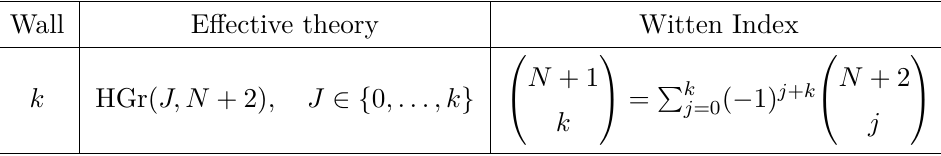
Table 2 . The k +1 domain wall solutions of 4 d N = 1 Sp( N ) SQCD with F = N +2 flavors in the regime m Λ . On the right we show how the various contributions to the Witten index from 4 d (cid:28) each solution sum up the Witten index of the pure Sp( N )